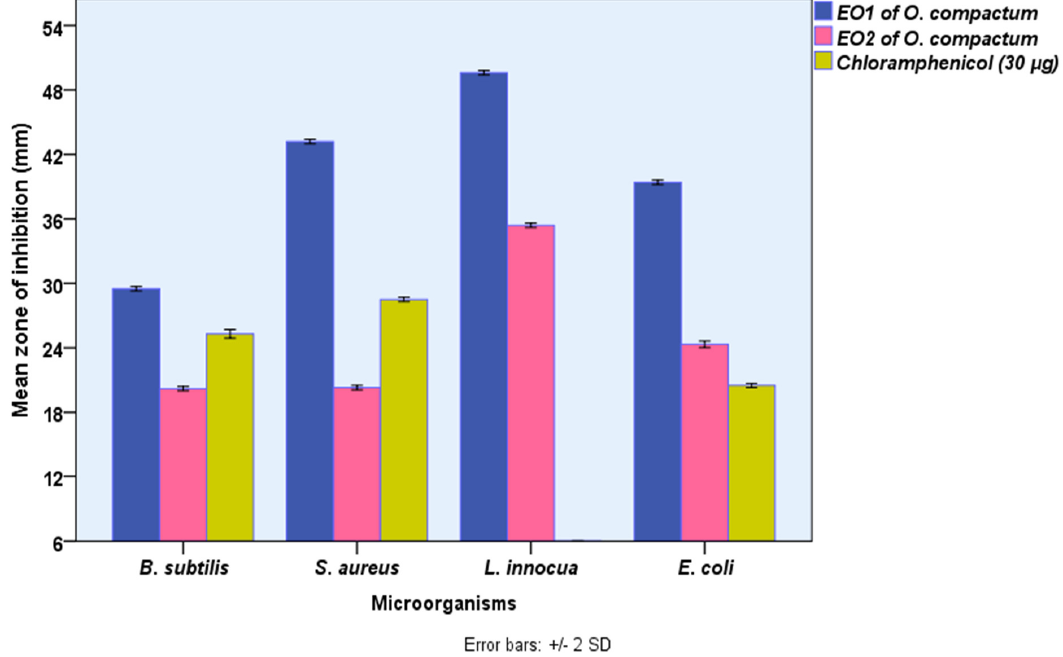
Figure 2. The antibacterial activities O. compactum EO from Boulemane region (EO1) and O. compactum EO from Taounat region (EO2) (paper disk zone ≤ 6.0 mm was ruled out).